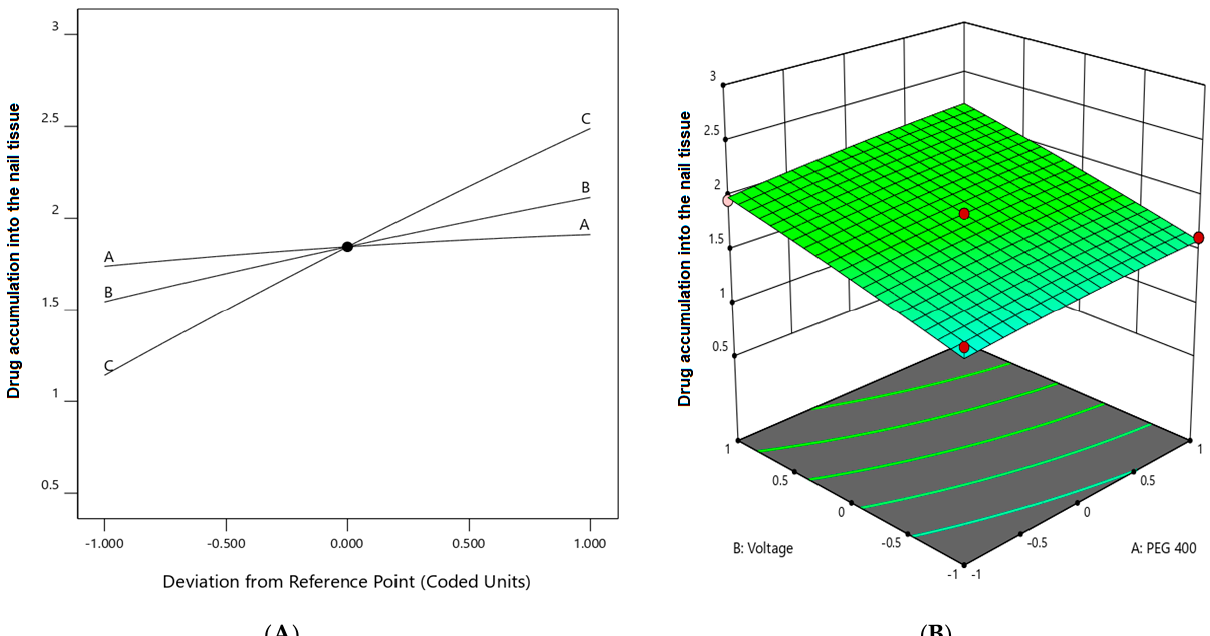
Figure 5. Effect of the independent variables on drug accumulation into the nail tissue ( A ) perturbation plot and ( B ) 3D surface plot.